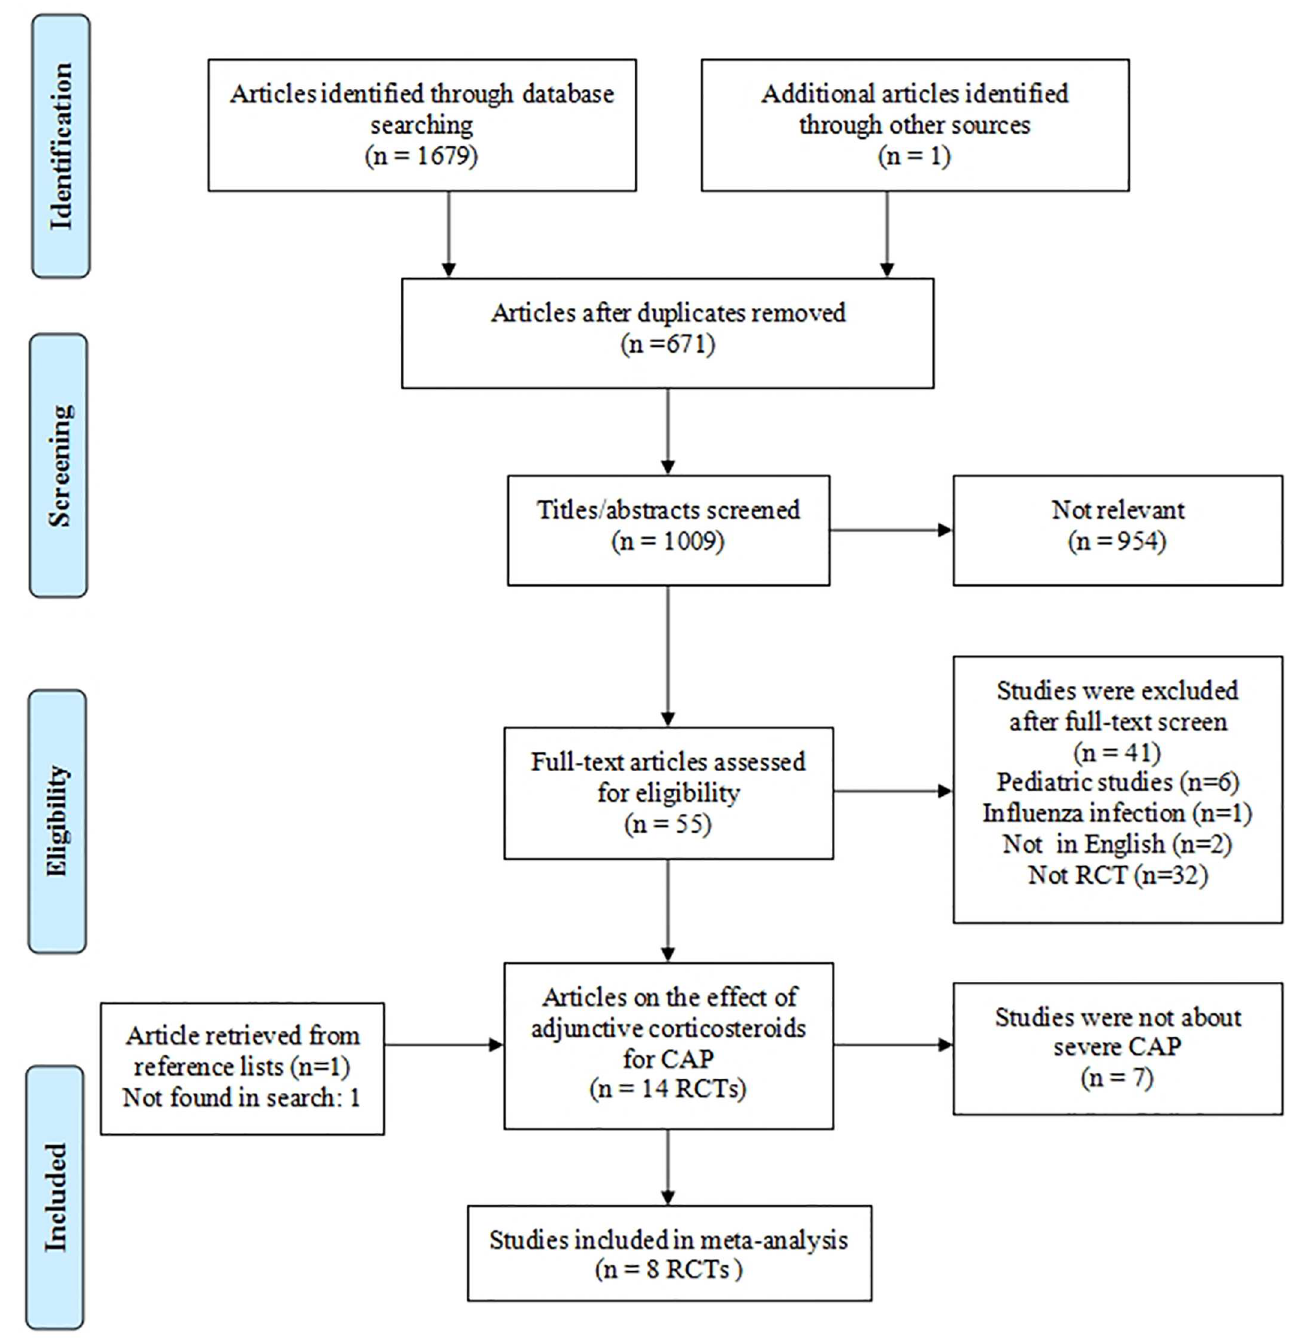
Fig 1. Flow diagram of the study selection